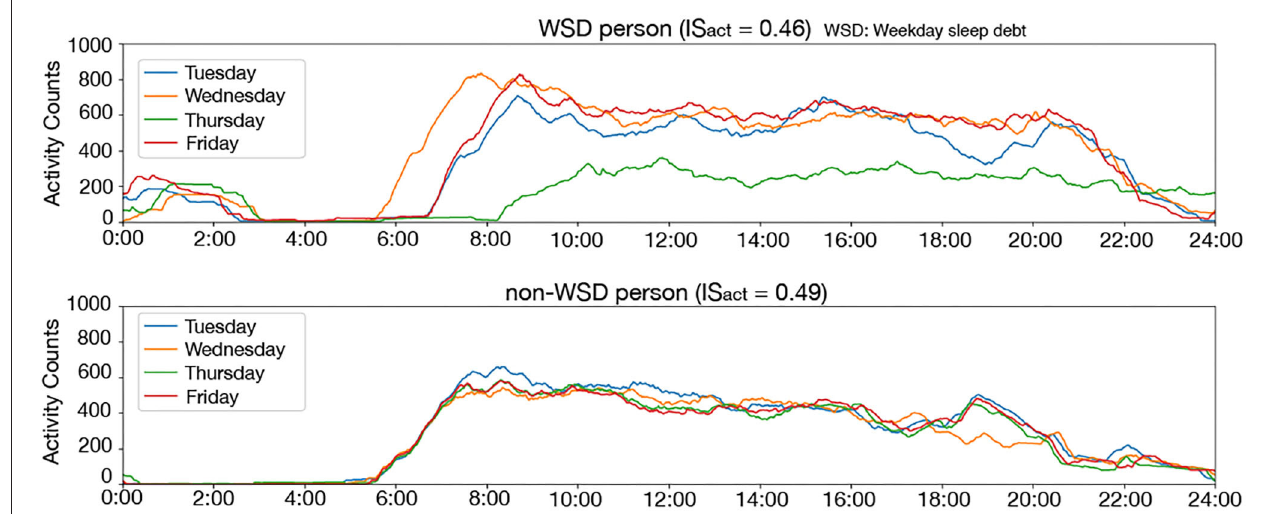
FIGURE 8 | Twenty four-hours activity counts on the weekday of a person with WSD (top) and without WSD (bottom) : the activity counts are smoothed by using the 60-min moving average for clear display. This figure clearly illustrates that the activity counts on Thursday were clearly different from other days in a person with